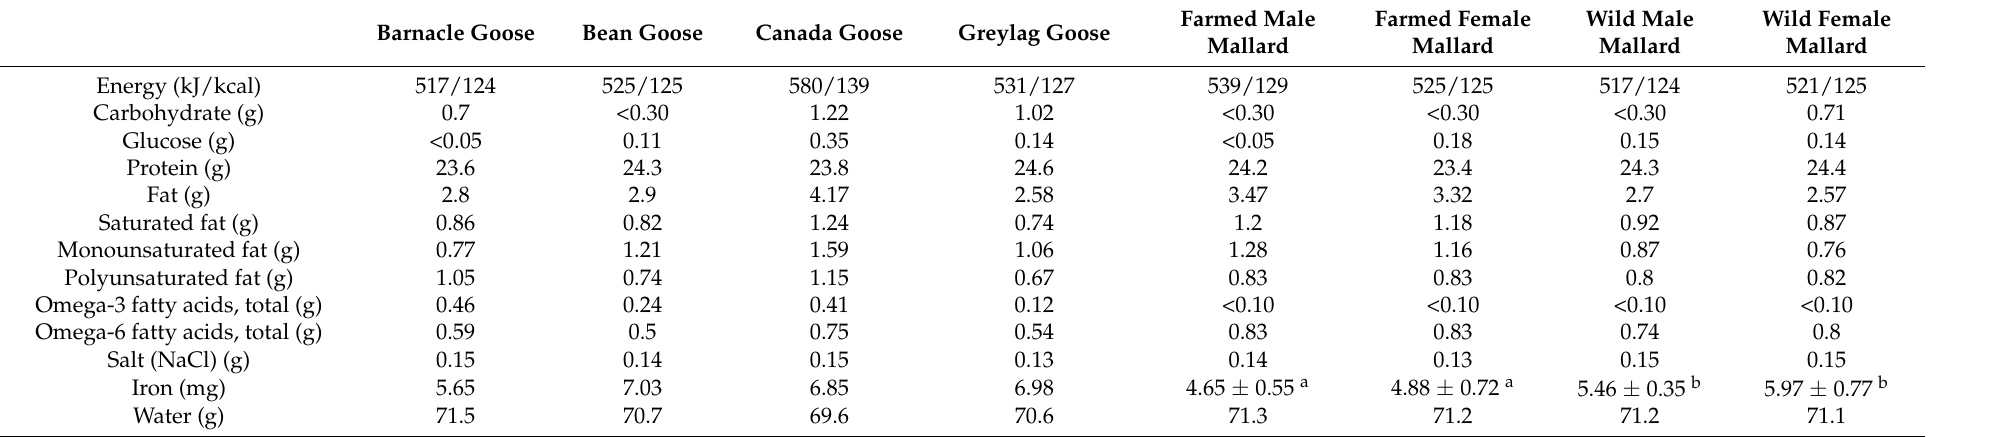
Table 2. Nutritional information per 100 g meat for all four species of goose, as well as farmed and wild mallards of both sexes. The values represent mean values based on pooled samples of six breast muscles from each group, except for iron content in mallards that was analysed separately for each individual, giving mean values ± sd. Significant differences in iron content are indicated with uppercase letters a and b .